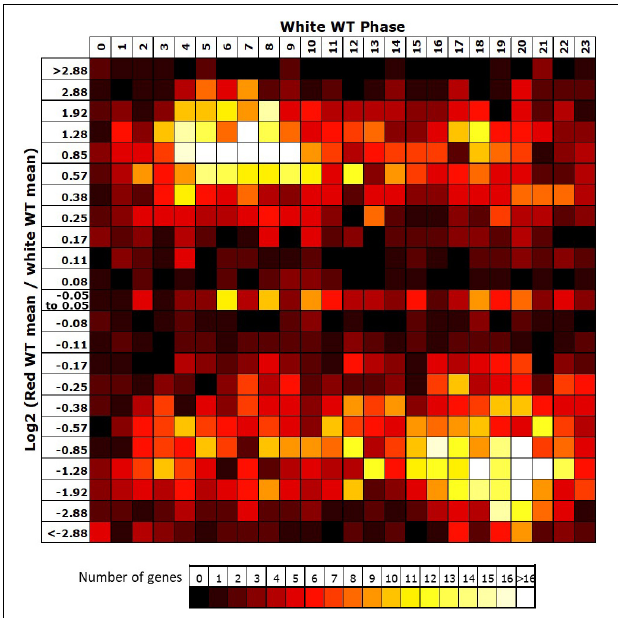
FIGURE 3 | Night-phased genes in white light show a loss of mean expression in red. For all genes identified as rhythmic in wild type (WT) in white light, the change in mean expression in red light was plotted against calculated phase in white light. Bins for log2 change in mean expression also follow a log2 progression. Each expression change bin covers the range up to the value indicated, starting from the value of the preceding